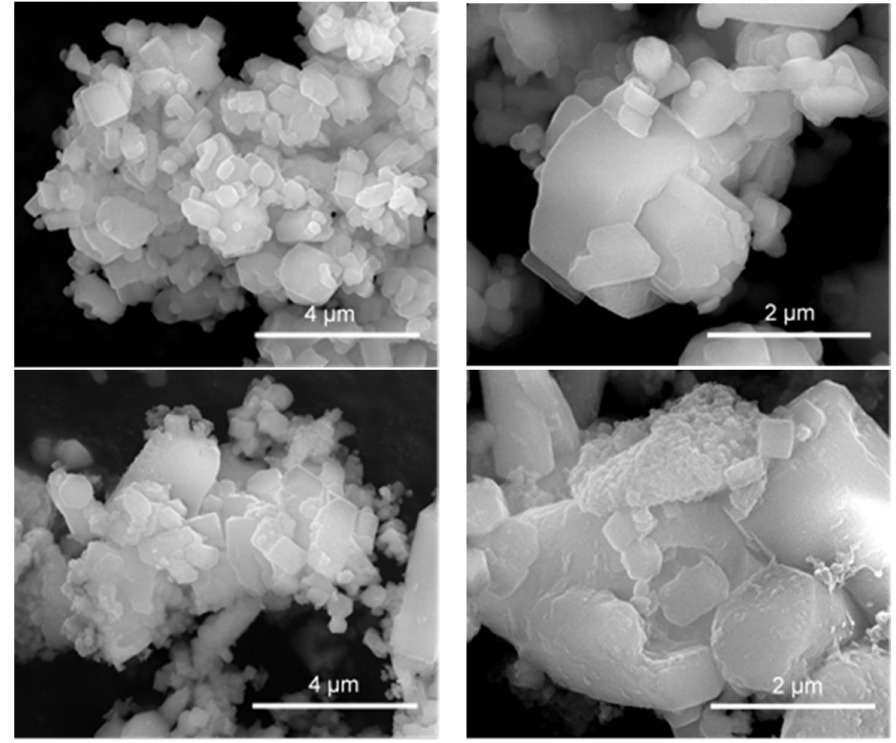
Figure 3. SEM images of the PMo 12 @MOF composite material before (top) and after (bottom) catalytic utilization (PMo 12 @MOF-ac) at different magnifications: (left) × 25,000 and (right) ×